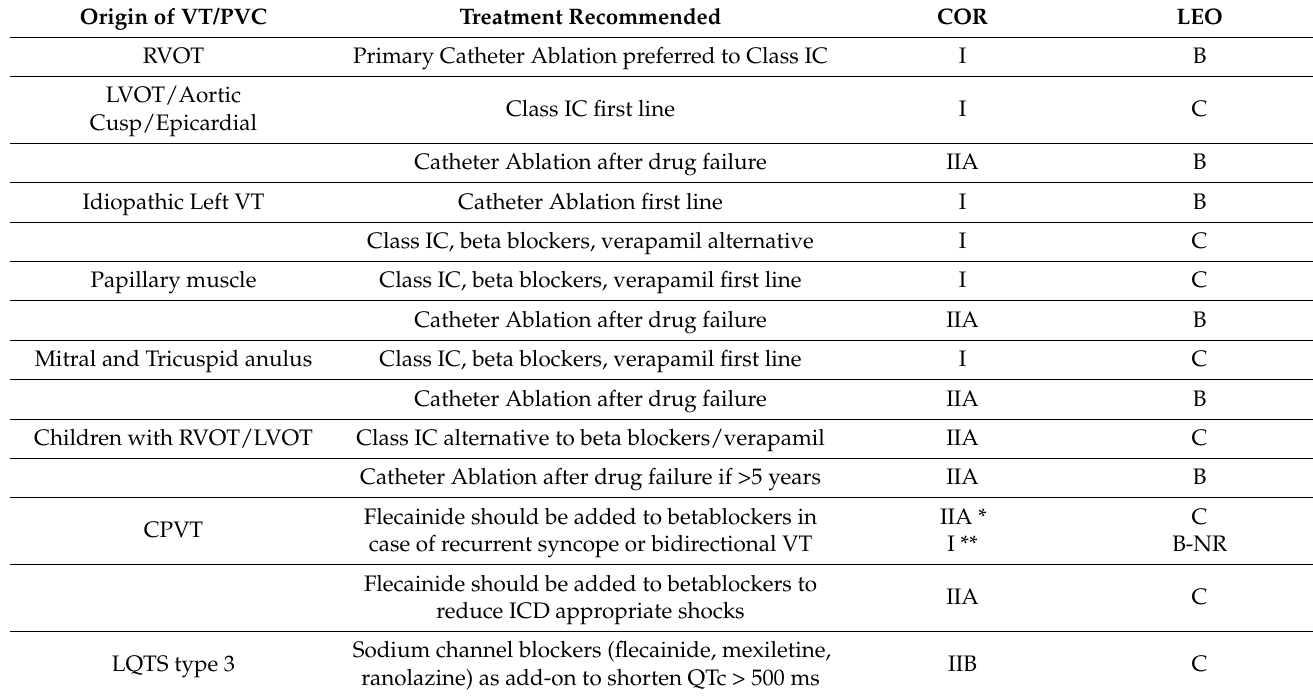
Table 1. Recommendations for immediate-release or controlled-release flecainide use in different clinical setting with the class of recommendation and level of evidence. RVOT = right ventricular outflow tract; LVOT = left ventricular outflow tract; VT = Ventricular Tachycardia; ICD = Implantable Cardioverter Defibrillator; COR = Class of Recommendation; LOE = Level of Evidence; NR= not randomized. * ESC Guidelines; ** AHA